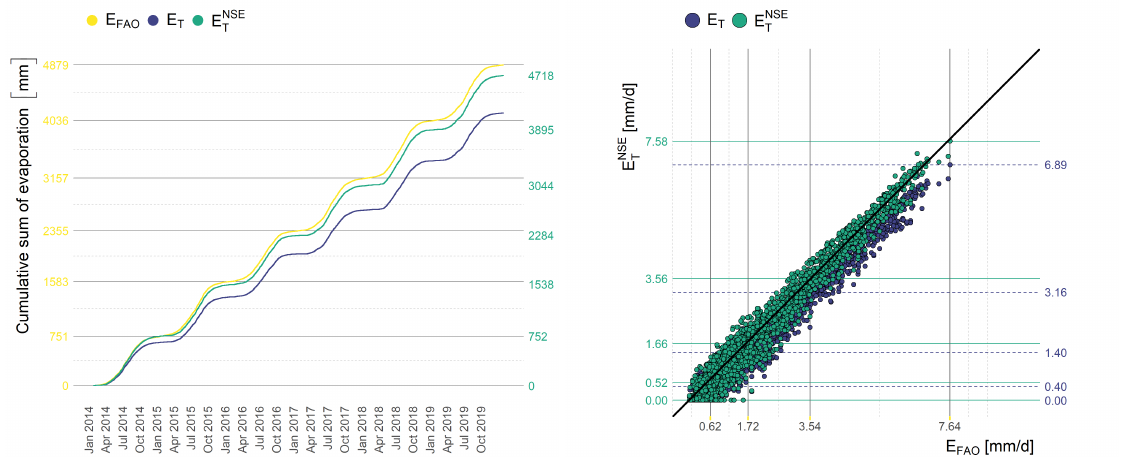
Figure 10. The comparison of the daily evaporation computed by FAO Penman–Monteith equation, Turc equation, and calibrated Turc equation with respect to NSE in the form of cumulative evaporation ( left ) and the scatter plot ( right